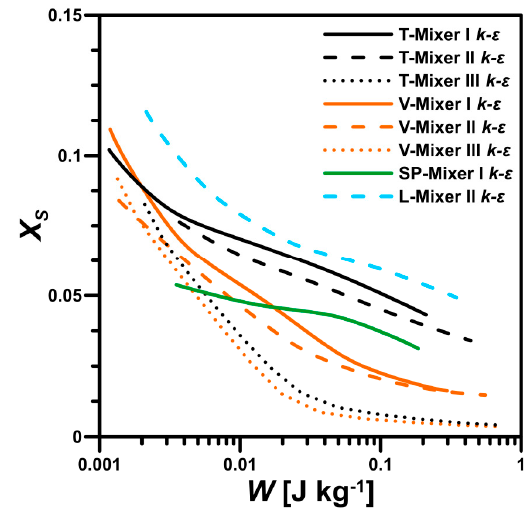
Figure 8. The energetic unit cost of obtaining product in different reactor types. Data for T-mixer I and T-mixer II from [15].